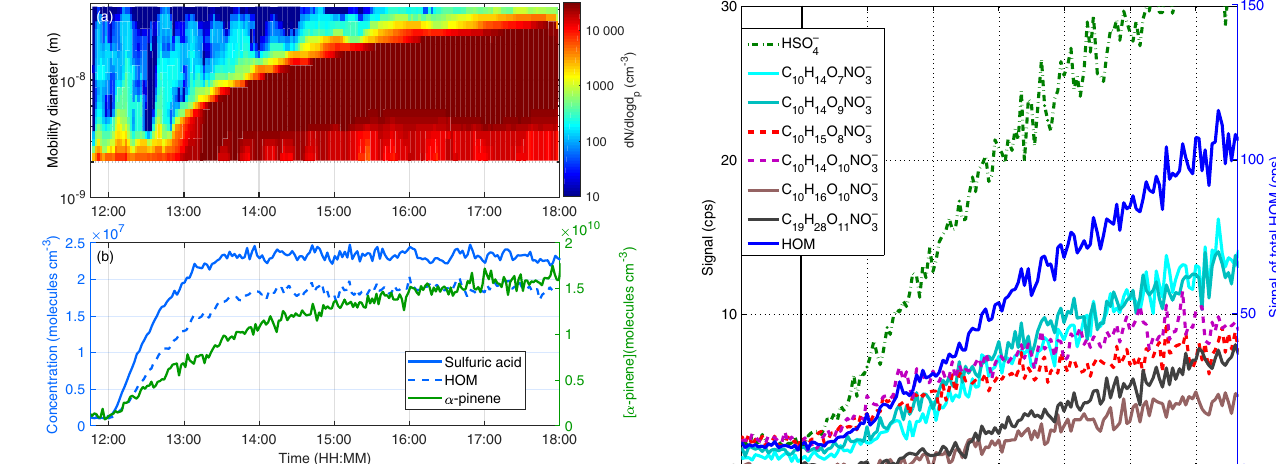
Figure 3. The time evolution of a bisulfate ion (green dotted line), total HOM (blue line) and the HOM signals of the highest concen- trations with 30s time resolution in an experiment with 600ppt of α -pinene and 67ppb of SO 2 . RO 2 signals are shown with dashed lines. All HOMs are detected as clusters with nitrate ions. The black line shows the start of the experiment (i.e. α -pinene